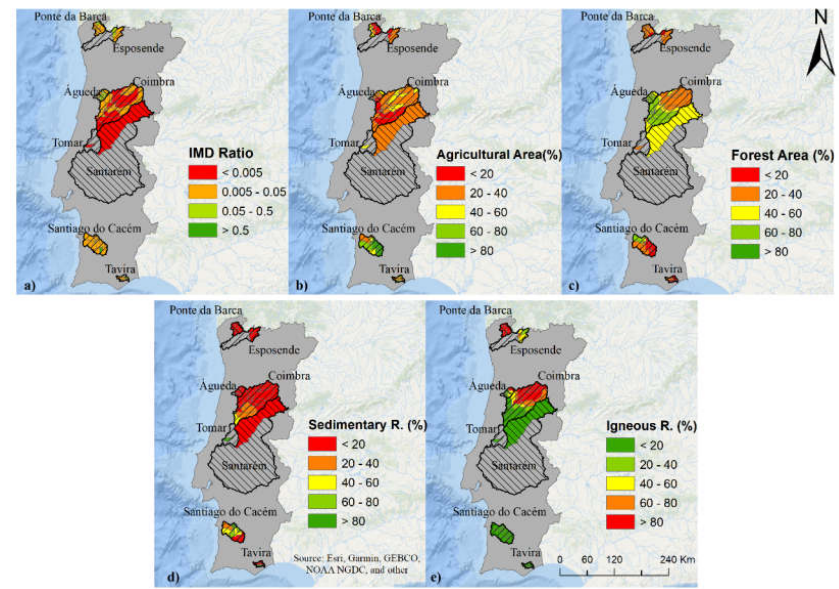
Figure 5. Spatial distribution of Land Use and Geology parameters. Only the variables used in the PLS-PM analyses are represented, namely: ( a ) IMD—Imperviousness ratio; ( b ) percentage of agricultural area in the watershed; ( c ) percentage of forest area in the watershed; ( d ) percentage of sedimentary rocks in the watershed; ( e ) percentage of igneous rocks in the watershed.